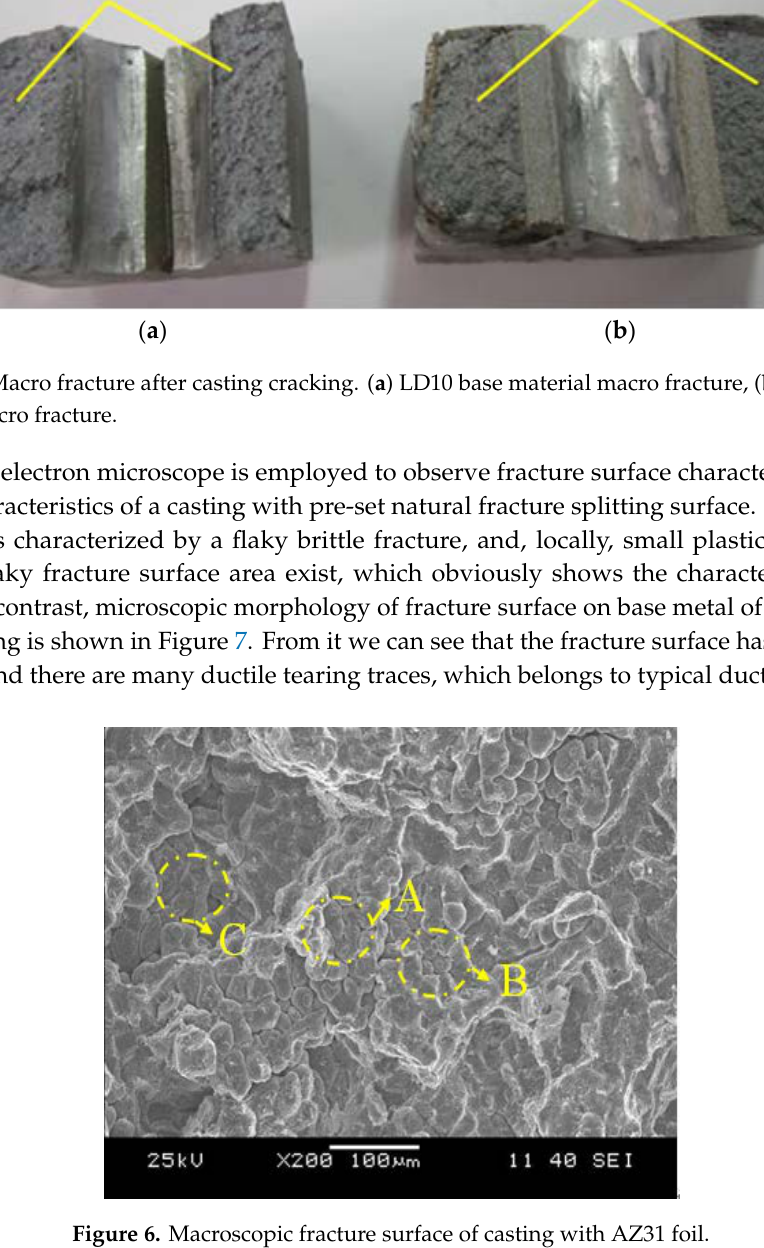
Figure 6. Macroscopic fracture surface of casting with AZ31 foil.